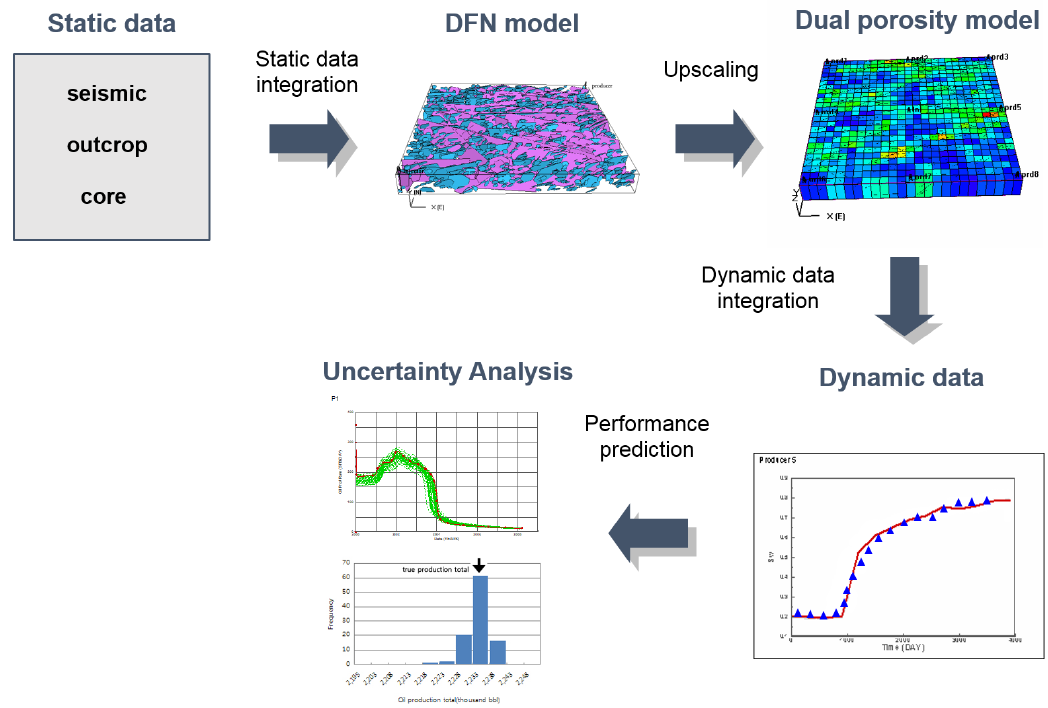
Figure 8. Workflow of fractured reservoir characterization and performance prediction.